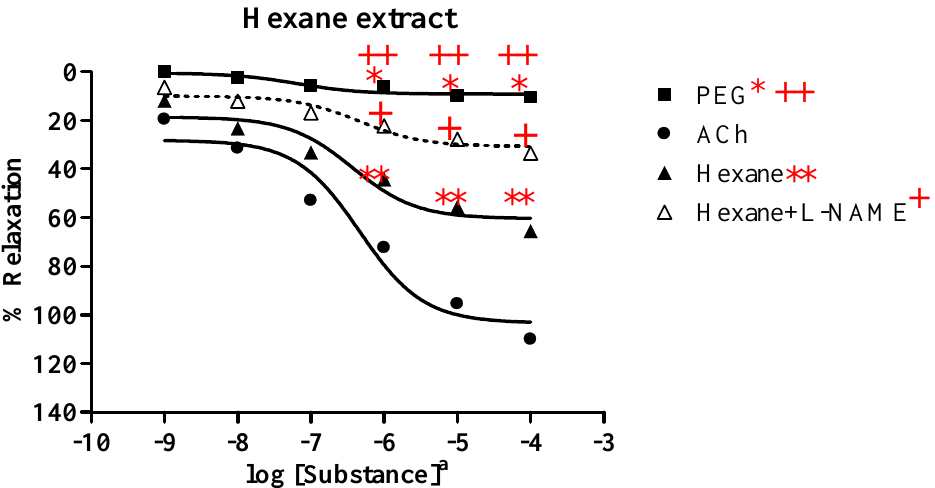
Figure 2. Effect of hexane extract on the vascular function of rat thoracic aorta in the absence or presence of NOS inhibitor ( L -NAME, 1 mM) compared with those of ACh and